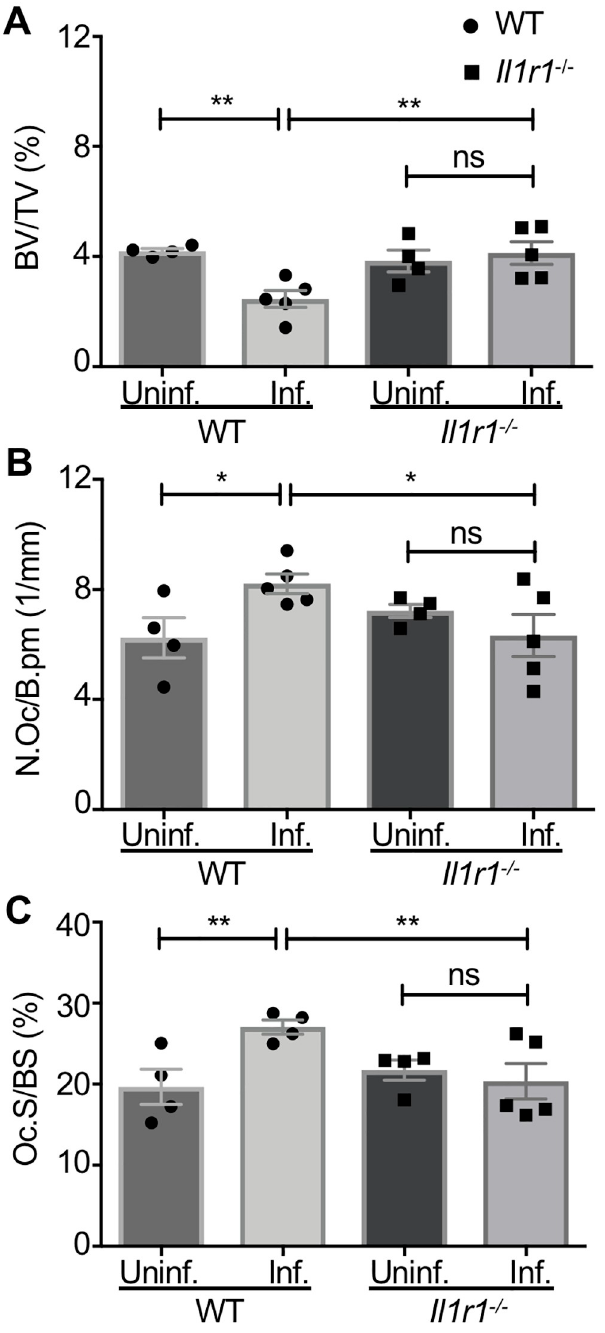
Fig 7. IL-1R contributes to infection-induced osteoclastogenesis during S. aureus osteomyelitis. (A-C) Following S. aureus infection (10 5 CFUs), female WT and Il1r1 -/- infected femurs ( n = 5 per genotype) and contralateral femurs from infected mice ( n = 4 per genotype) were harvested, decalcified, processed for sectioning in paraffin, and TRAP- stained for histomorphometric analyses using OsteoMeasure software. Histomorphometric analyses of S. aureus infected femurs and contralateral femurs from infected mice were quantified to calculate the trabecular bone volume/ total volume (BV/TV) (%) (A), the number of osteoclasts per bone perimeter (N.Oc/B.pm) (1/mm) (B), and the osteoclast surface per bone surface (Oc.S/BS) (%) (C) in the distal femur. Symbols represent individual data points from each mouse (WT = circles; Il1r1 -/- = squares), the top line of each bar represents the mean, and error bars represent standard deviation. All statistical comparisons used a two-way ANOVA and Fisher’s Least Significant Difference (LSD) test to compare differences in trabecular bone composition of infected and contralateral, uninfected femurs of WT and Il1r1 -/- mice. � p < 0.05, �� p < 0.01, ns = not significant.